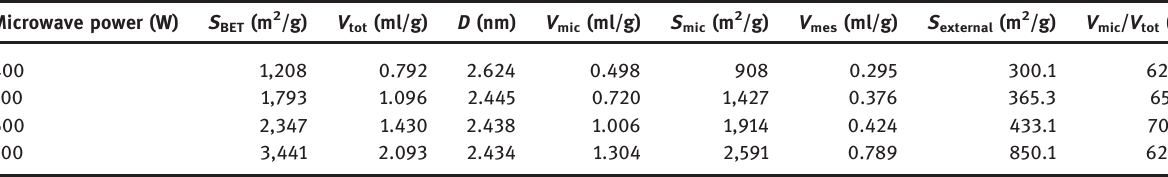
Table 1: Details of pore structure of activated carbon with different microwave power. Microwave power